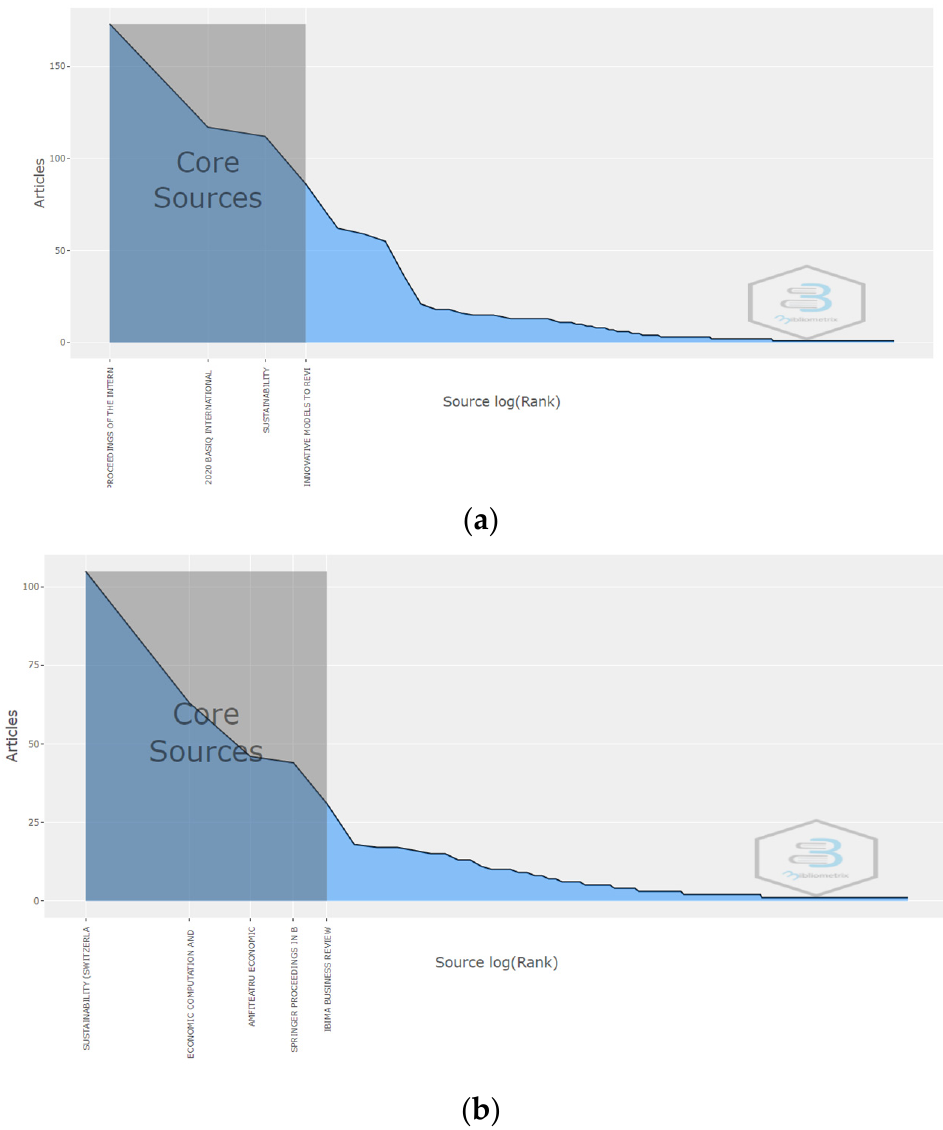
Figure 4. Bradford’s Law. ( a ) WoS. ( b ) Scopus. Table 3 shows the list of most essential sources arranged in the decreasing order of h-index and with a value of h-index > 2. Sustainability and Lancet are the journals with the highest h-index of 12 and 9 on WoS and 11 and 10 on Scopus. Egghe pointed out the relevance of the g-index seen as an extension of the h-index and represents an essential tool for assessing the global citation performance [51]. Costas and Bordons pointed out that the g-index offers a better ranking position than the h-index [52]. Sustainability gains visibility and ranks first with the total number of citations (919 on WoS and 559 on Scopus), according to the total number of